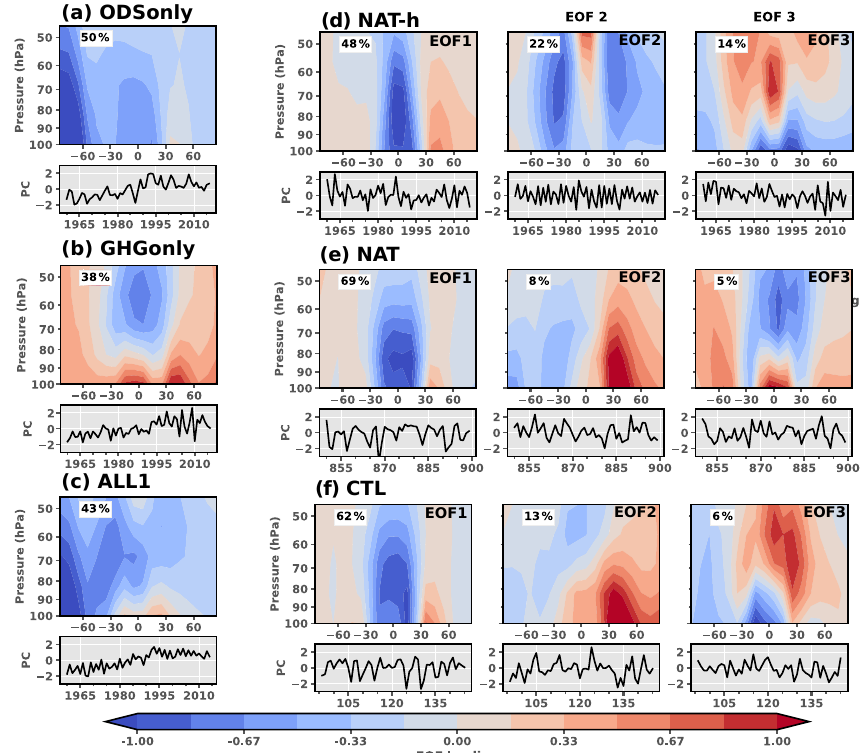
Figure 6. Same as Fig. 5 but for the lower